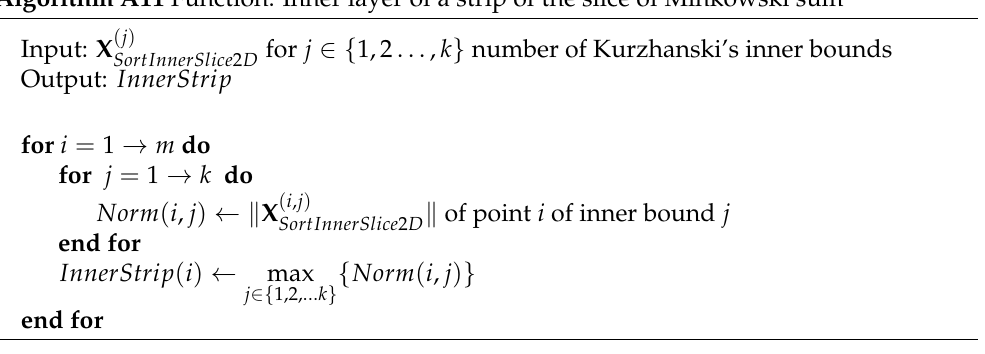
Algorithm A11 Function: Inner layer of a strip of the slice of Minkowski